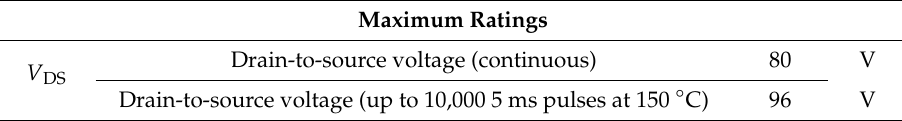
Table 3. Data from an E ffi cient Power Conversion EPC2021 datasheet